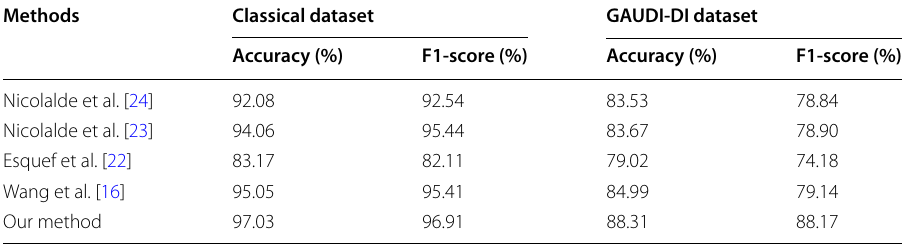
Table 3 Comparison with the state-of-the-art methods